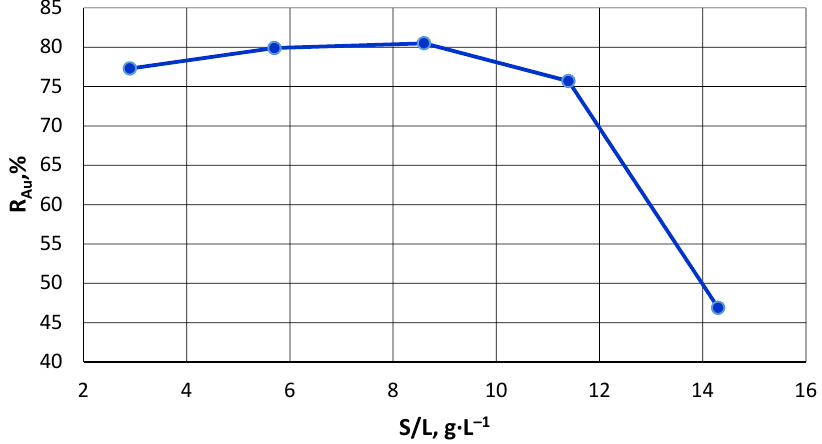
Figure 8. Impact of S/L ratio on the degree of gold leaching. Experimental conditions: Raw material fraction [A], C HCl = 6 M, i = 0.66 A · cm –2 , and t ex = 2 h.